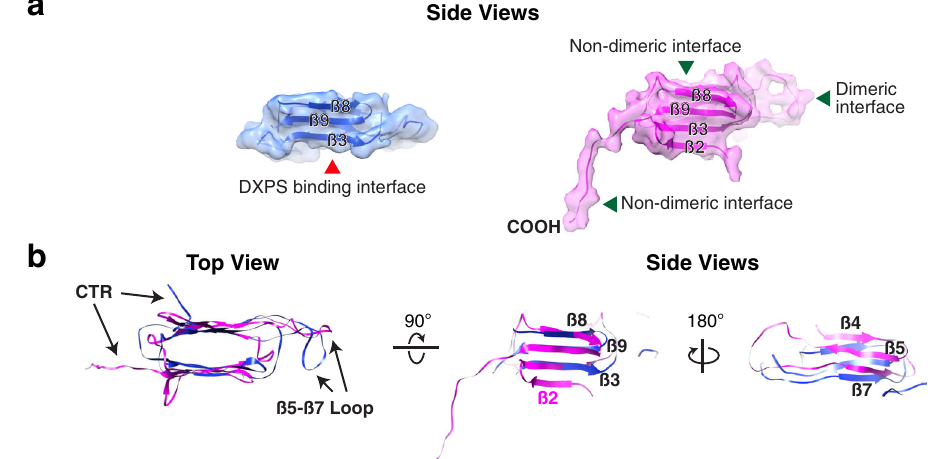
Fig. 4 Structure comparison between Hsp21 monomers from Hsp21-DXPS and the Hsp21 dodecamer. a Side view of map segments fi tted with the model of the Hsp21 monomer from Hsp21-DXPS (left, blue) and the Hsp21 dodecamer (right, magenta). The beta strands on one sheet of the ACDs are labeled for side-by-side comparison. Note the missing of the beta2 strand in the Hsp21 monomer (blue) derived from the Hsp21-DXPS complex. The DXPS binding, dimeric and non-dimeric interfaces of Hsp21 are labeled. b Superimposition of the two models viewed from different directions. For the side views, the back side of ACD was clipped for clarity. The β 5- β 7 loops and the CTRs on both monomers which they exhibit different conformations are labeled. Twisting of the beta sheets of the ACD from the Hsp21 dodecamer is revealed through overlay of the models (middle and right).